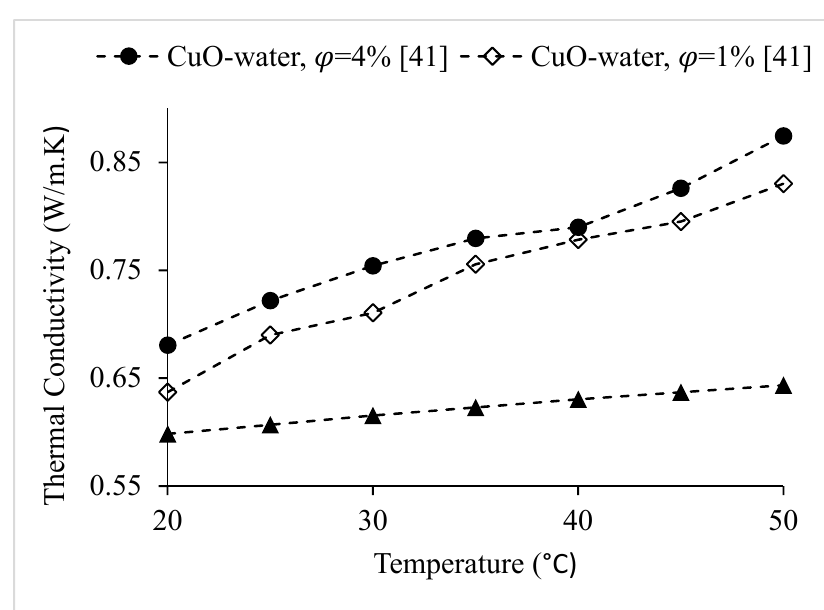
Figure 22. Variation of the thermal conductivity of ZnO–water nanofluid at various nanoparticle volume concentrations, as a function of temperature.